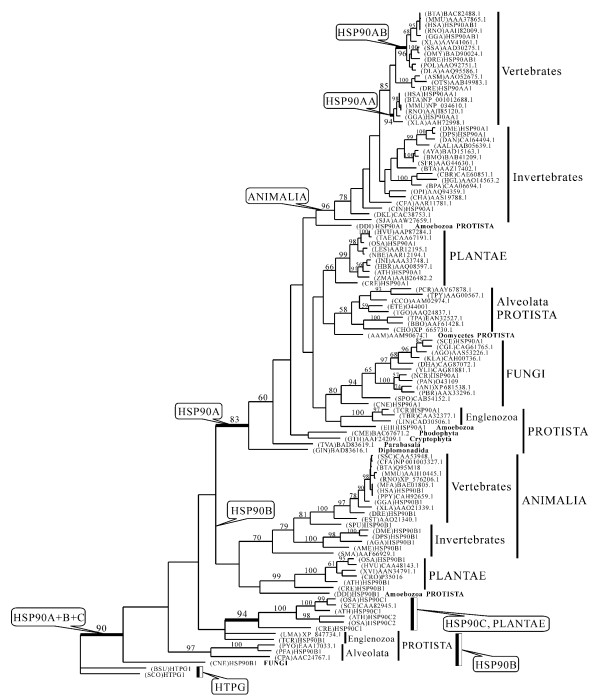
Most parsimonious tree inferred from HSP90A+B+C proteins, rooted with bacteria HTPG proteins. Bootstrap percentages of 5000 replicates are shown above the branches where they exceed 50%. Branch lengths are proportional to number of character changes.